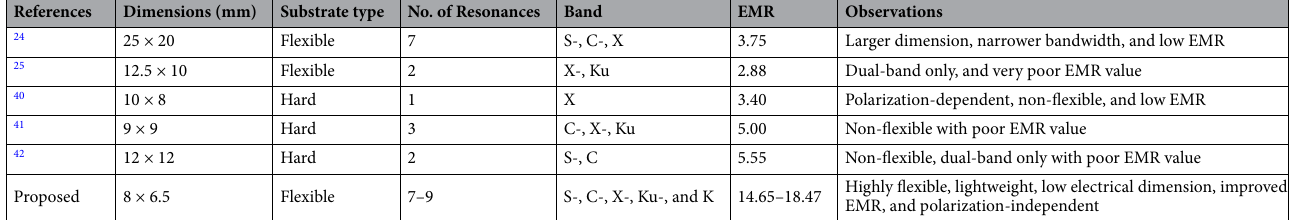
Table 6. Comparison of proposed metamaterial with some existing